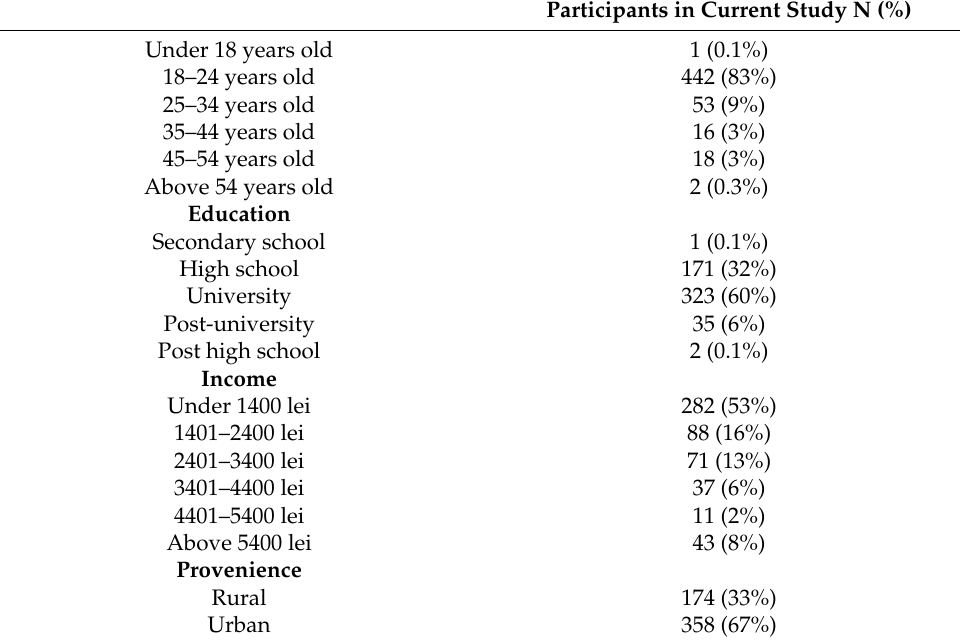
Table 2. Descriptive statistics.